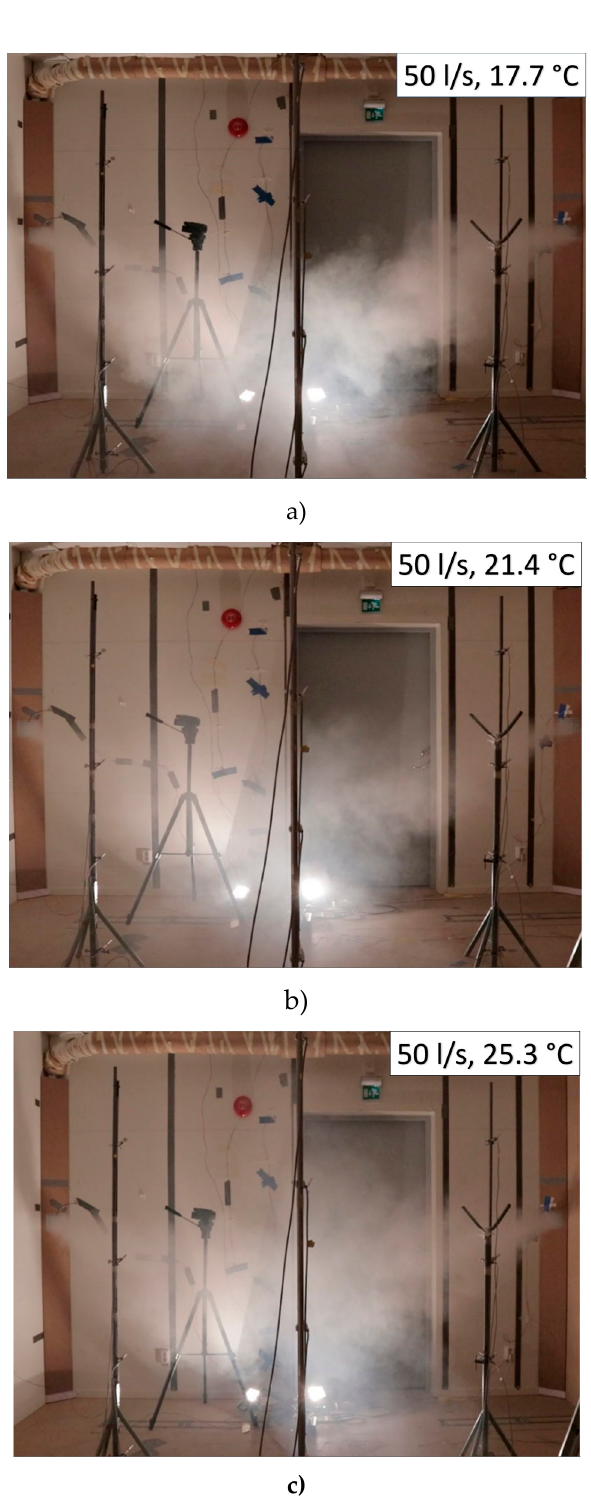
Figure 3. Flow visualization: ( a ) air flow patterns at 50 l/s and 17.7 °C, ( b ) air flow patterns at 50 l/s and 21.4 °C, ( c ) air flow patterns at 50 l/s and 25.3 °C.